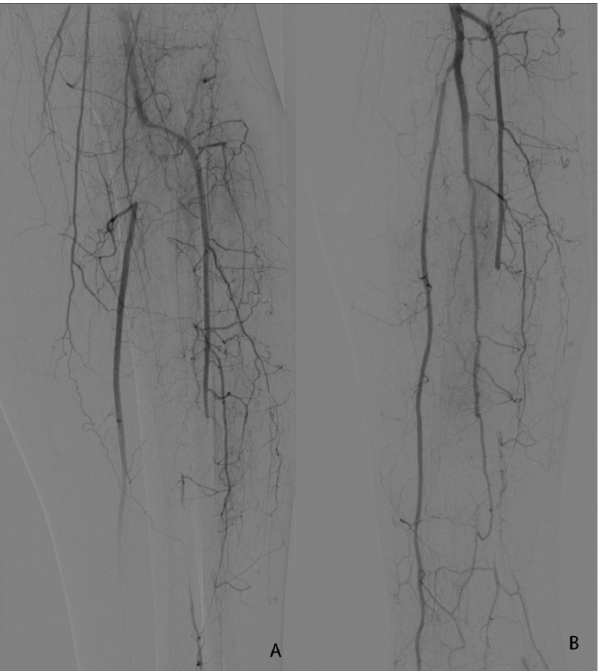
Figure 4. ( A , B ). Seldinger angiography of a 64 yo patient with stage IIB Rutherford acute lower left limb ischemia 2 days after SARS-CoV-2 diagnosis. ( A )—initial image before thrombolysis initiation. ( B )—final image after balloon angioplasty of the initial segment of the posterior tibial artery.